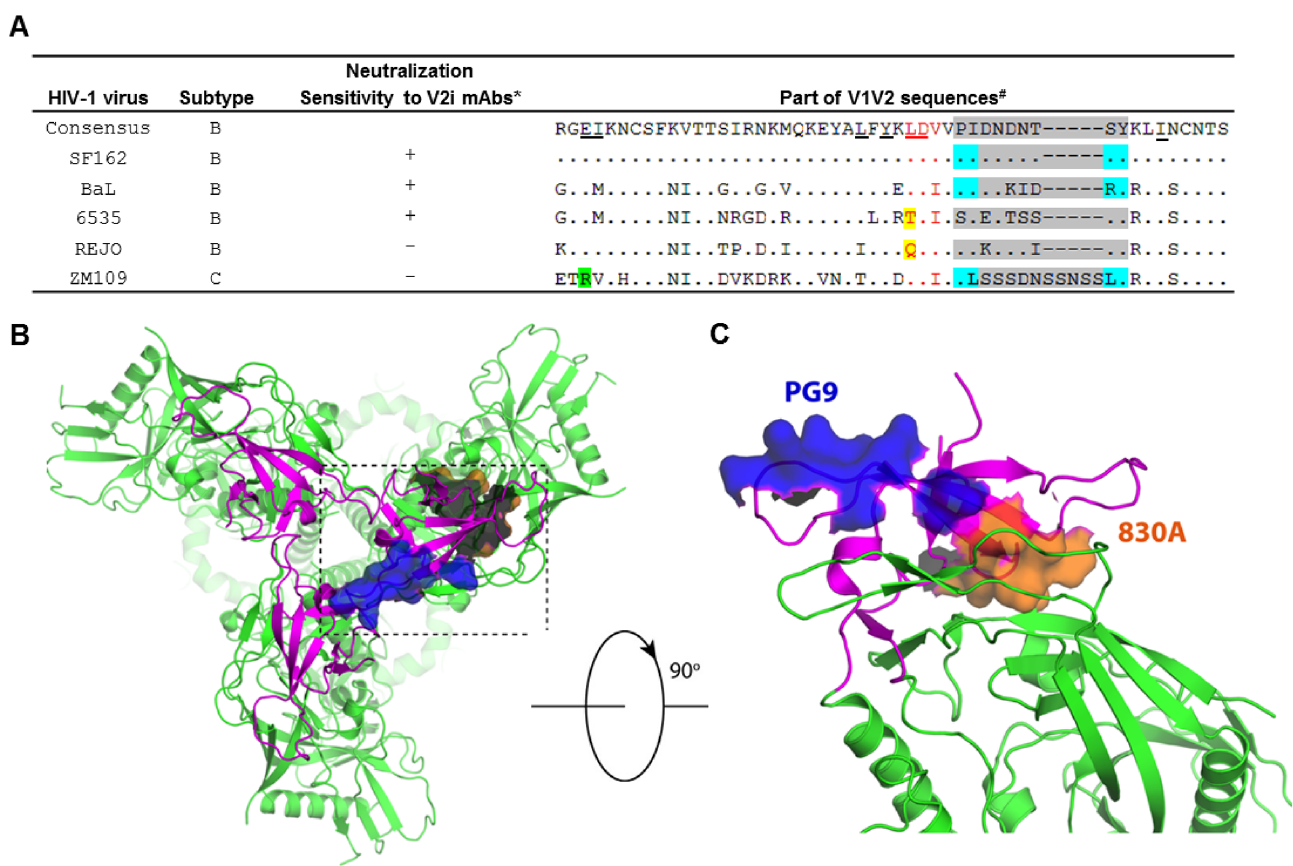
Fig 1. Alignment of V1V2 sequences from HIV-1 isolates tested and the HIV-1 Env trimeric structure with the 830A epitope. (A) Comparison of V1V2 sequences from HIV-1 isolates tested in this study. These five viruses display distinct neutralization sensitivity to V2i mAbs [12]. The key contact residues for mAb 830A are underlined. The integrin α 4 β 7-binding motif 179 LDV/I 181 is shown in red, and amino acids that diverge from this motif are highlighted in yellow. The green highlight shows a distinct amino acid at position 153 in the V1 loop of the ZM109 strain. The gray highlight shows the sequence and length of the hypervariable V2 loop. To stabilize the flexible hypervariable V2 loop, disulfide bonds were introduced at positions highlighted in blue (183 – 191 and 184 – 190). (B) The surface of V2i mAb 830A epitope is illustrated on the pre-fusion Env trimer represented by the BG505 SOSIP structure (PDB Code 4TVP). The gp120 trimer is shown as ribbons and the V1V2 regions are colored in magenta. The 830A-binding site surface is colored in orange. However, since this surface faces down from this top view, only the majority of the backside (colored in dark grey) is seen. The surface of the PG9 epitope (colored in blue) is shown as a reference. (C) A zoom-in of the 830A epitope surface from an angle of view about 90 degree rotated from that in Fig 1B. For clarity, only one gp120 is